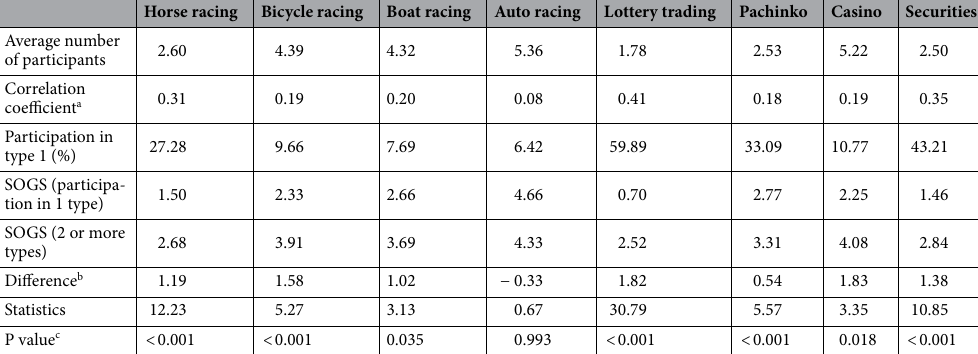
Table 4. Number of participants and SOGS scores by gambling type (n = 14,780). a Correlation coefficient between average number of participants and SOGS scores. b Test for differences between single type and two or more types. c Boat racing and casinos significant at p < 0.05, auto racing not significant.